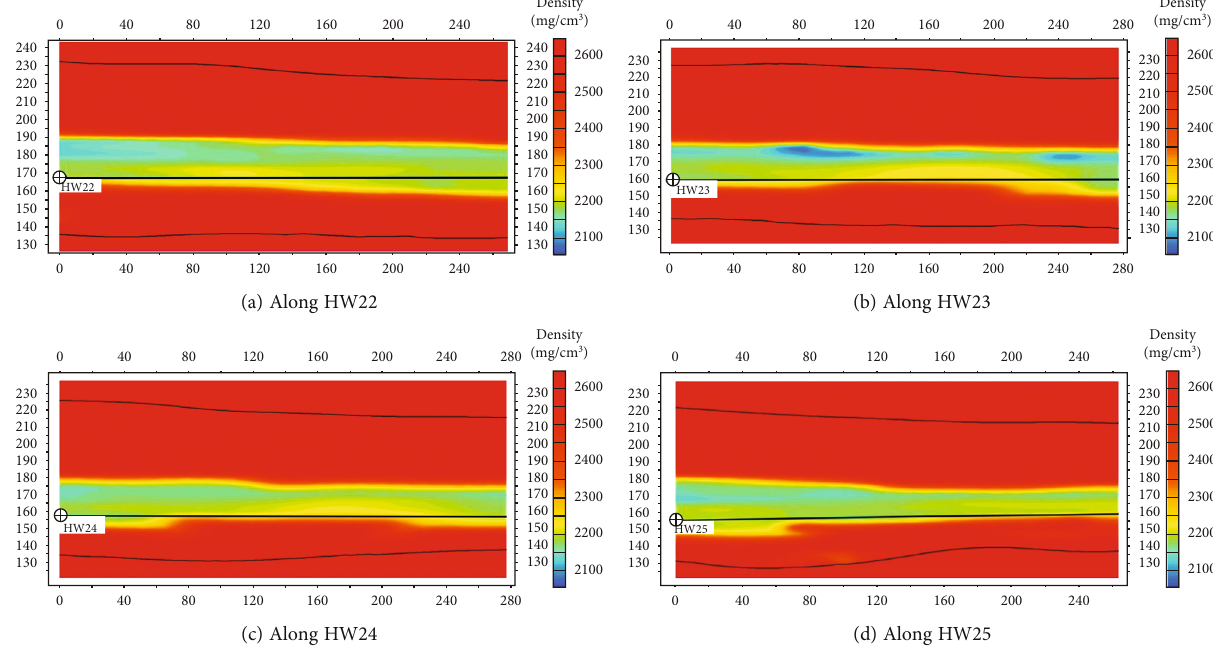
Figure 6: Inversion density pro fi les along di ff erent horizontal wells.